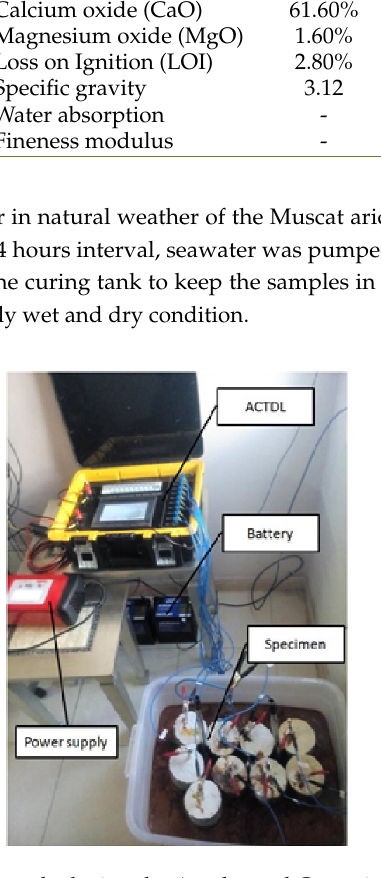
Fig. 3. Sample during the Accelerated Corrosion Test